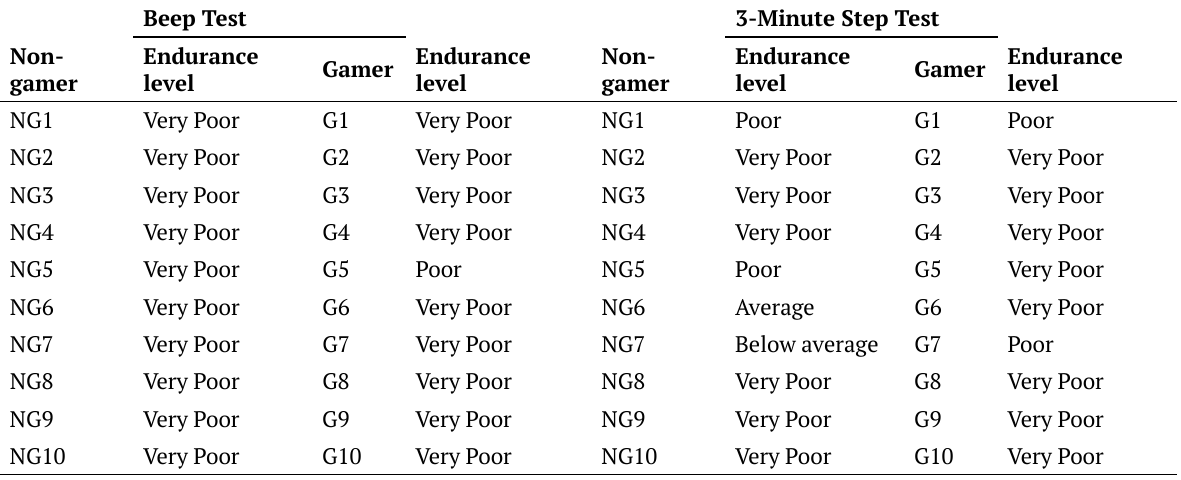
Table 2. Contingency table on participants’ endurance level based on Beep and 3-minute step test